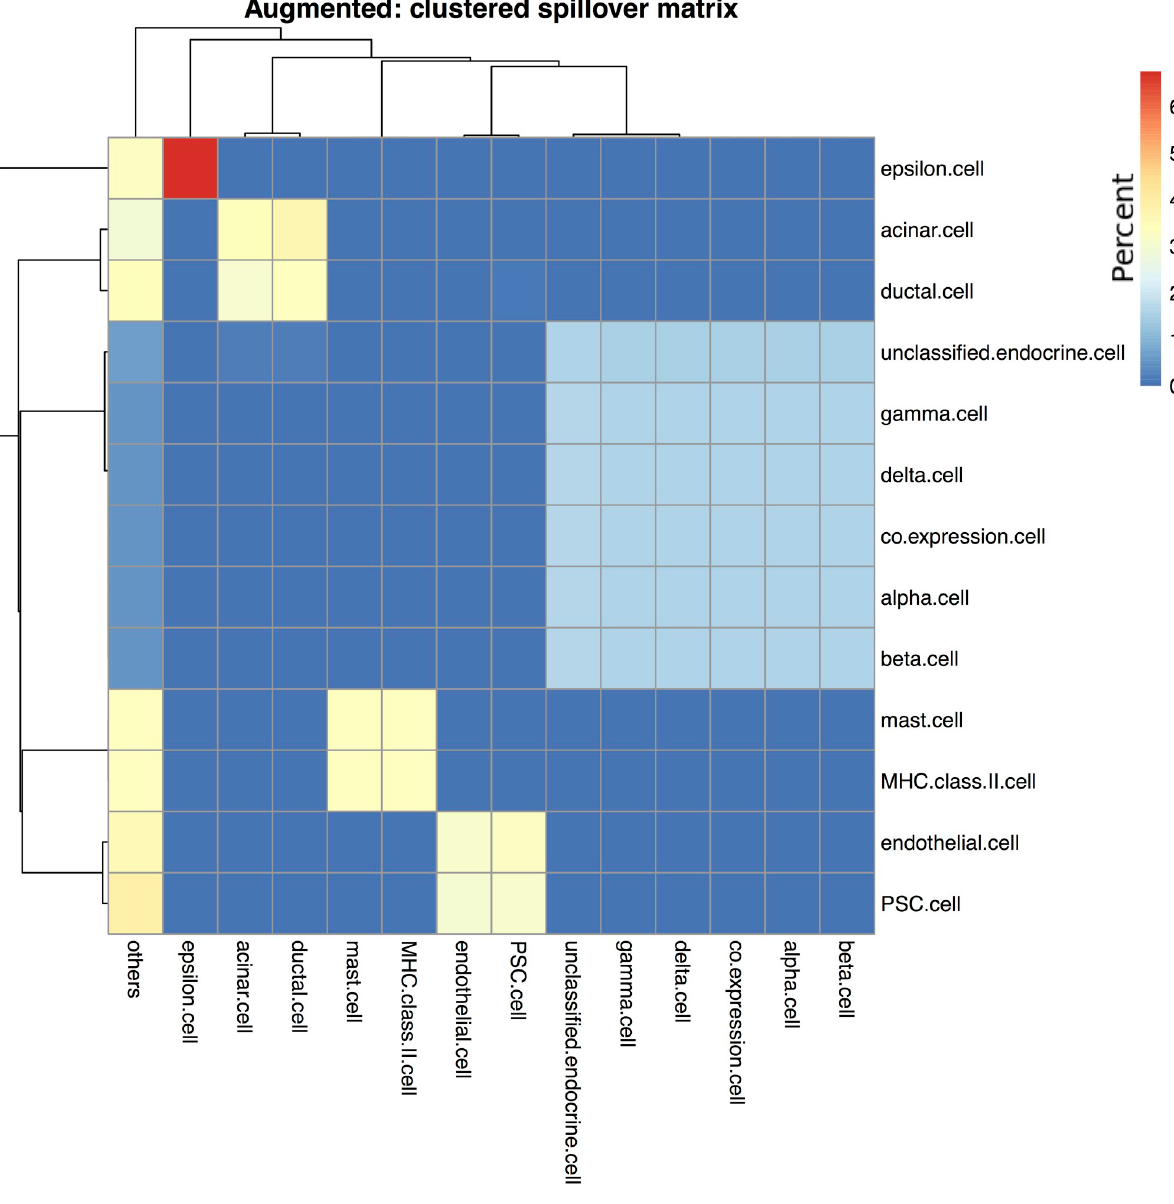
Fig 7. Clustering of augmented gene signature matrix. The cell type clusters identified using the augmented signature matrix that was seeded with the 100 genes exhibiting the highest variance in the normal pancreas sample. Rows show purified cell types and columns show what those samples deconvolve as. Cells are colored by percentage, such that each row adds up to